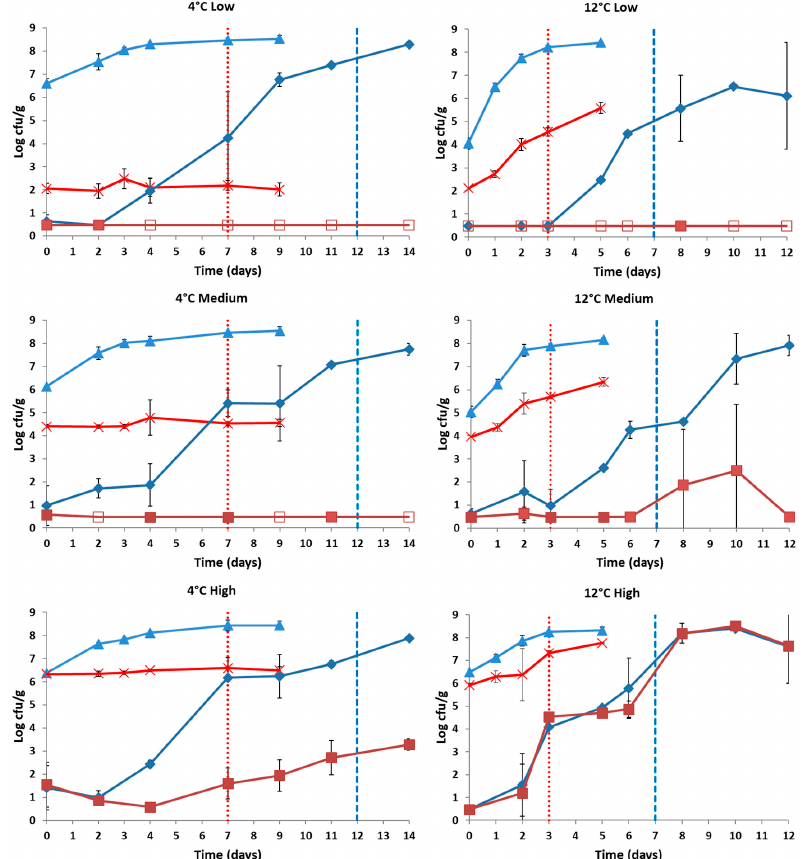
Figure 2. Growth curves of TVC on untreated ( ▲ ) or HPP–treated (500 MPa/10 min) ( ♦ ) chicken fillets and of L. monocytogenes on untreated (x) or HPP–treated (500 MPa/10 min) ( ■ ) chicken fillets inoculated with low, medium, and high inoculum level of a 4-strain cocktail of Listeria monocytogenes and stored under vacuum package at 4 °C (left) and at 12 °C (right). Open symbols ( □ ) indicate absence of the pathogen after applying the enrichment method. Vertical red dotted line: end of the control samples shelf-life according to sensory analysis. Vertical blue dashed line: end of the HPP-treated samples shelf-life according to sensory analysis. Error bars represent the mean values ± standard deviation.